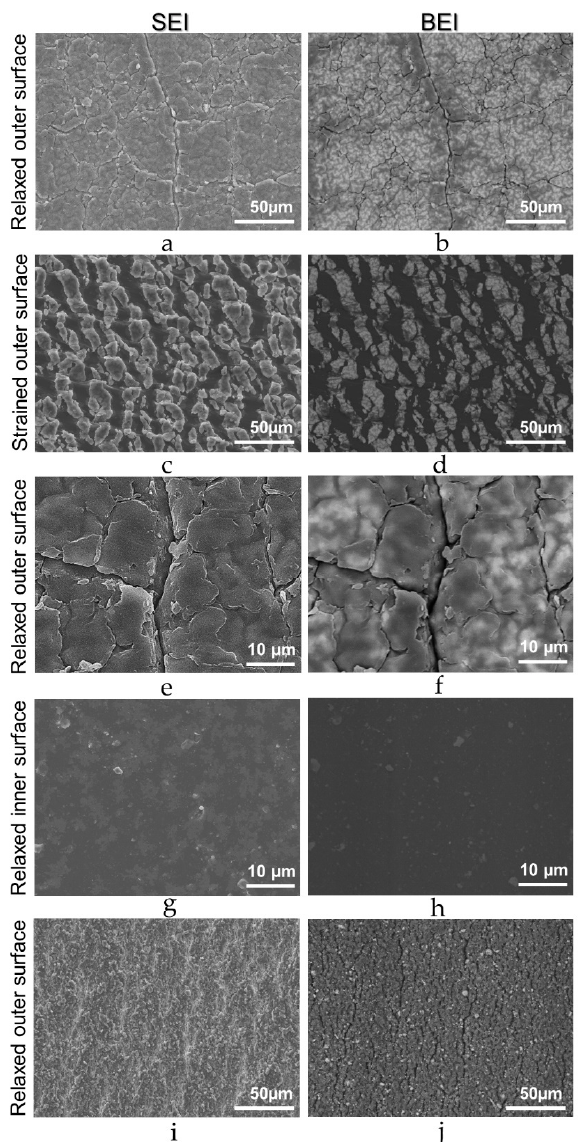
Figure 3. SEI (left side) and BEI (right side) micrographs acquired from S tubing outer surface, either relaxed ( a , b , e , f ) or strained ( c , d ). Relaxed inner S tubing micrographs are ( g ) (SEI) and ( h ) (BEI). Micrographs of the unstrained L sample outer surface are ( i ) (SEI) and ( j )